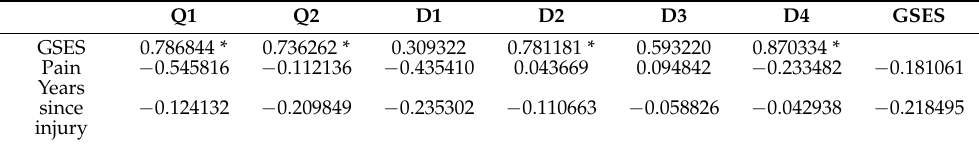
Table 3. Spearman’s rank-order